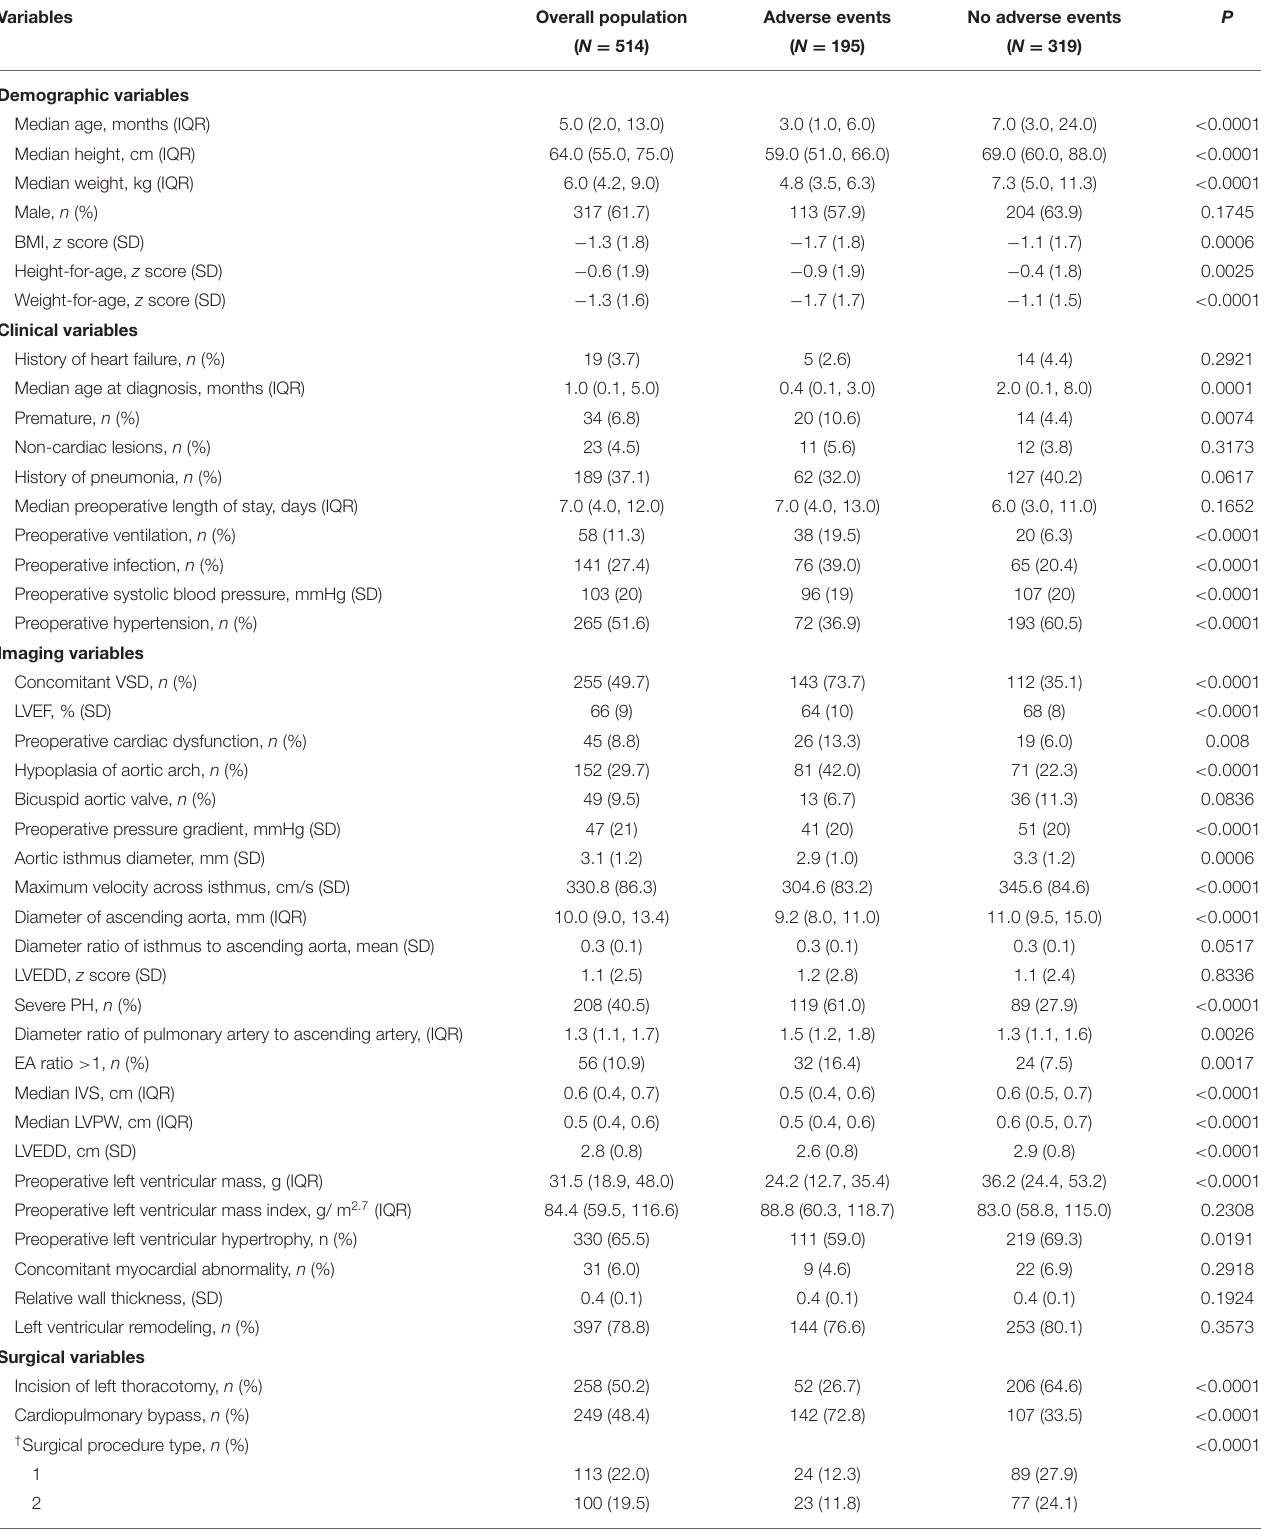
TABLE 1 | Baseline clinical characteristics of CoA patients with and without adverse events ( N = 514)*.